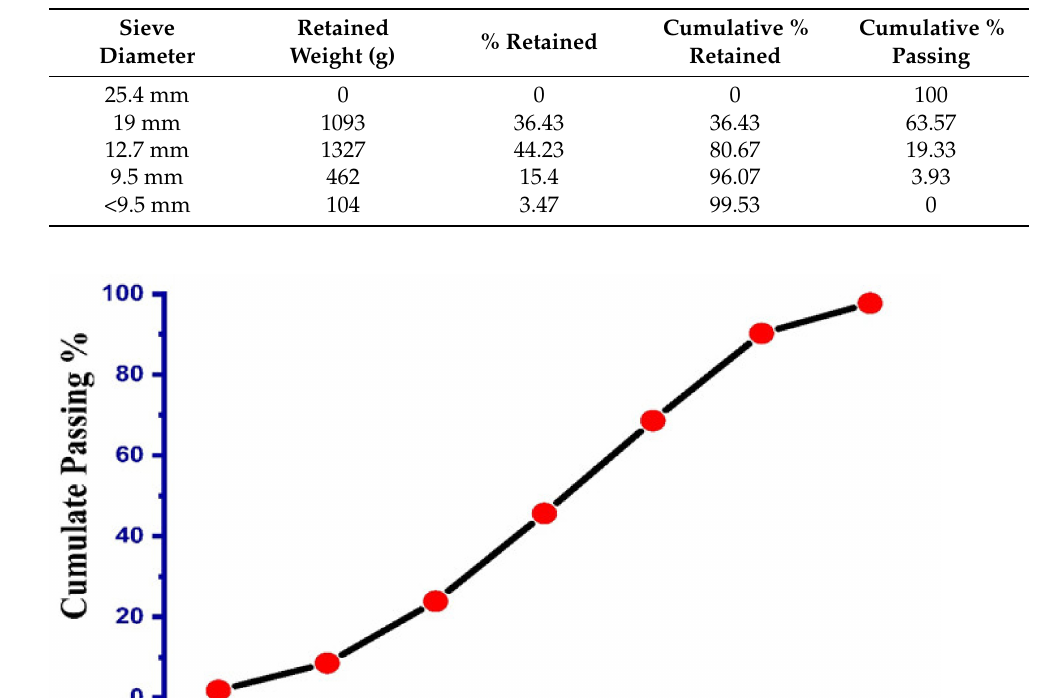
Table 3. Grading analysis of coarse aggregate.